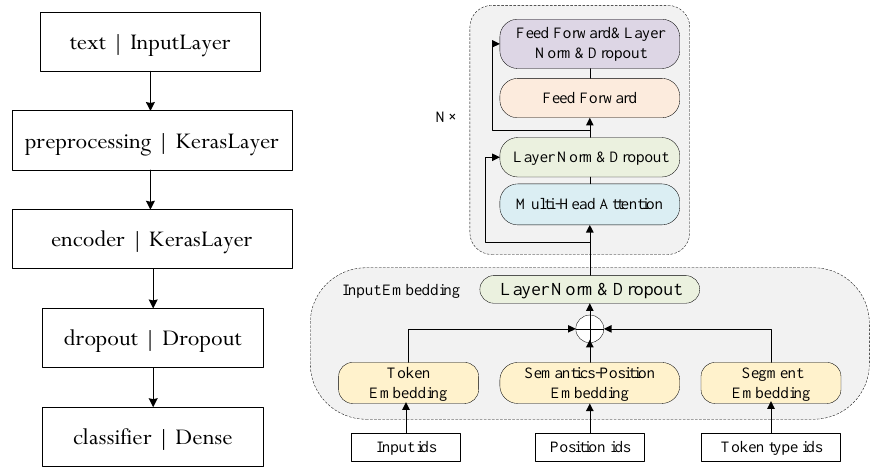
Figure 5. The structure of synBERT.